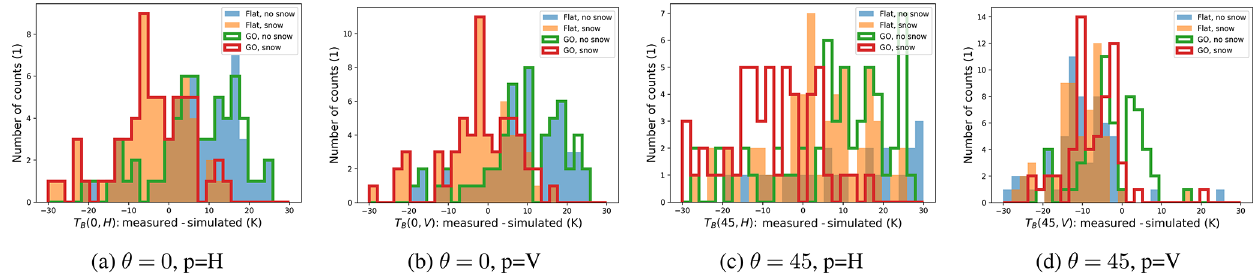
Figure 11. Histograms of the differences between the EMIARAD2 measurements and simulation setups for four antenna feeds. Table 3. Performance metrics for the different T B simulation setups in terms of coefficient of determination r 2 , RMSE (K), and bias (K). For EMIRAD-2 channels four model setups are tested: Flat no snow, Flat snow, GO no snow, and GO